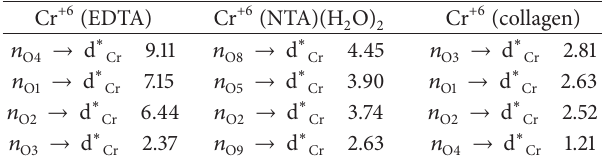
Table 4: Higher energies of nonbonding interactions between NBOs in the coordination sphere for complexes of Cr +6 kcal ⋅ mol −1